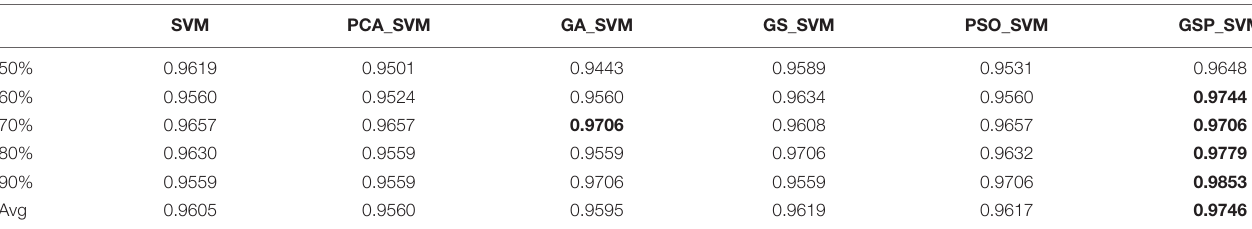
TABLE 3 | The experimental results of classification accuracy of